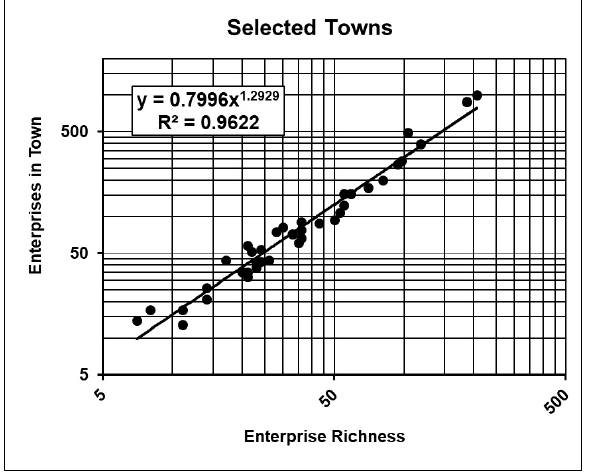
The power law (log-log) relationship between enterprise richness and the number of enterprises in the towns selected for this